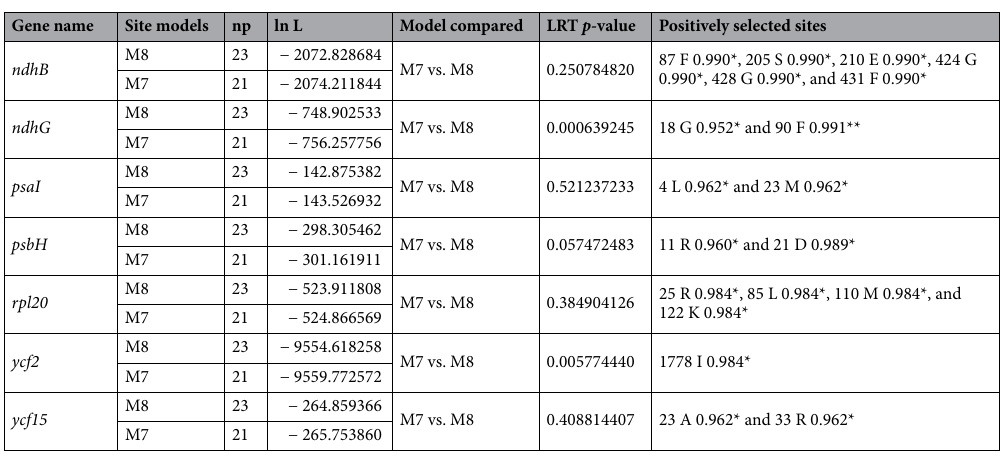
Table 3. Positively selected sites with dN/dS values > 1 detected in two Launaea and eight Reichardia chloroplast genomes. np: number of parameters in the ω distribution; ln L: log-likelihood values; LRT p-value: likelihood ratio test p-value; positive selection sites are inferred by significant posterior probability value with * > 0.95 or ** > 0.99.